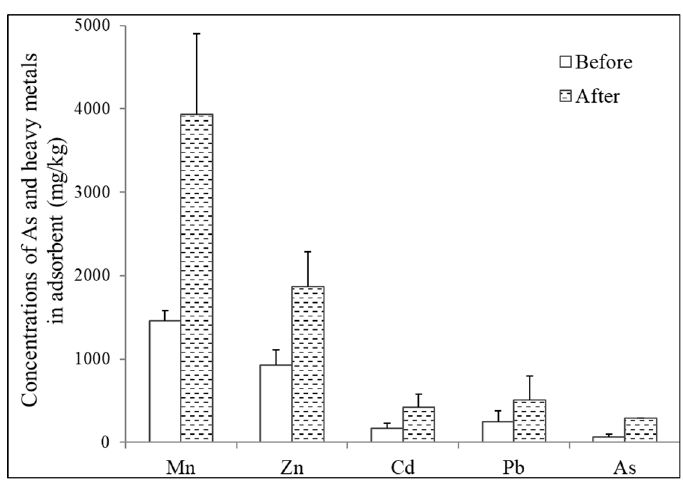
Figure 3. Concentrations of As and heavy metals in the adsorbent (mg/kg) after 4 months.